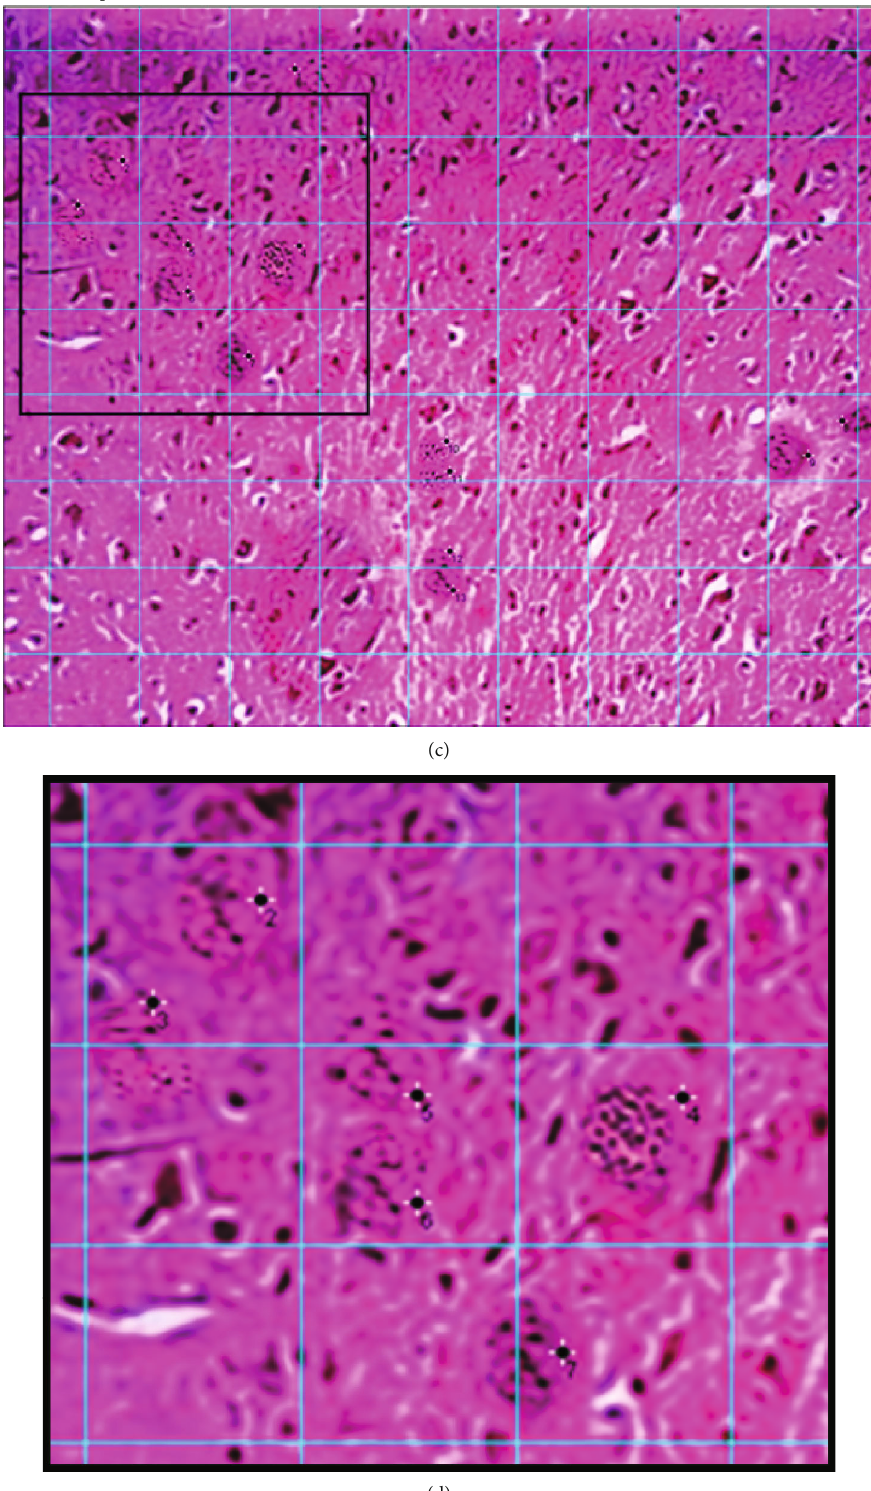
Figure 2: Estimation process of the T. gondii cysts in brain tissue-cut sections stained with H&E in a magni fi cation power (40x). Quanti fi cation was based on creating an image grid (in blue colour) with the ImageJ software and manual selection of the parasites (asterisk with numbers) within the boundaries of the grid. (a) A partial hippocampus region with clusters of cysts (28 cysts), and (c) shows separate cysts (13 cysts) in the amygdala region. Note that (b, d) are cropped magni fi ed portions from (a) and (c),